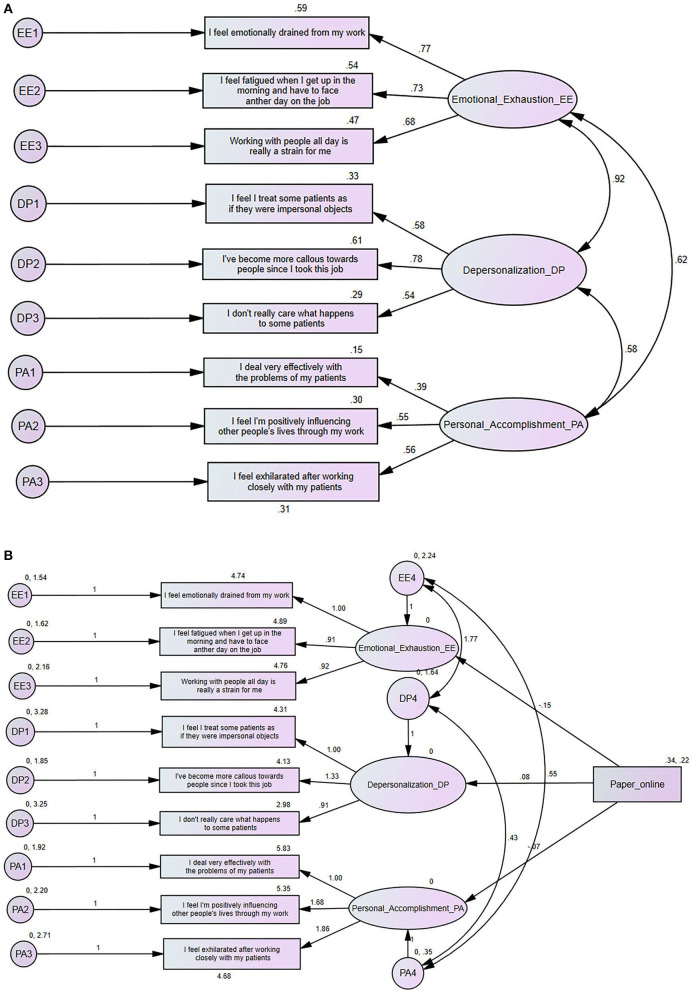
(A) Standardized parameter estimates for the factor structure of the Abbreviated Maslach Burnout Inventory (aMBI). (B) Multiple indicator multiple cause (MIMIC) structural equation model for for differential item functioning (DIF) based on paper or online method.